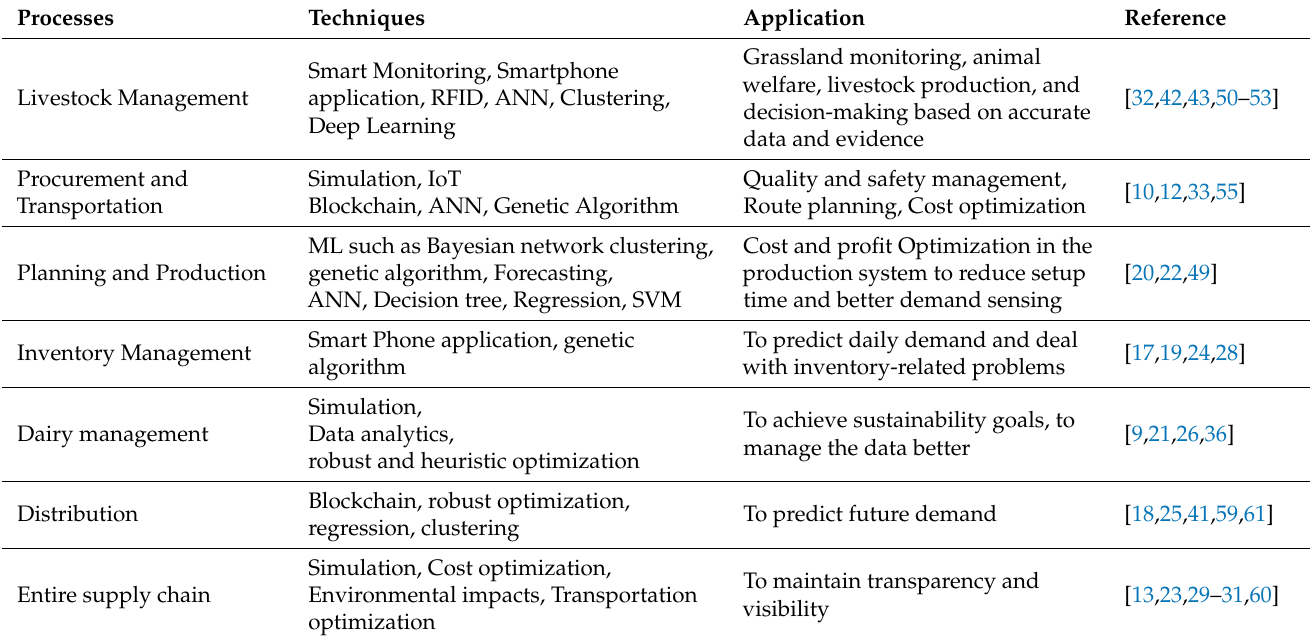
Table 3. Technologies utilized in